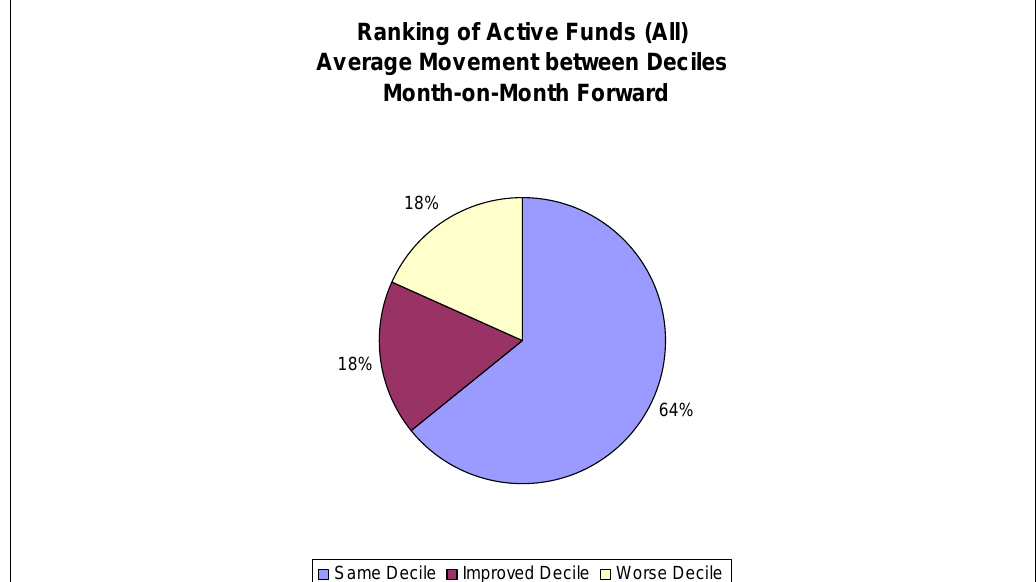
Figure 4: Tendency of actively managed funds to move between deciles on a month-to-month basis